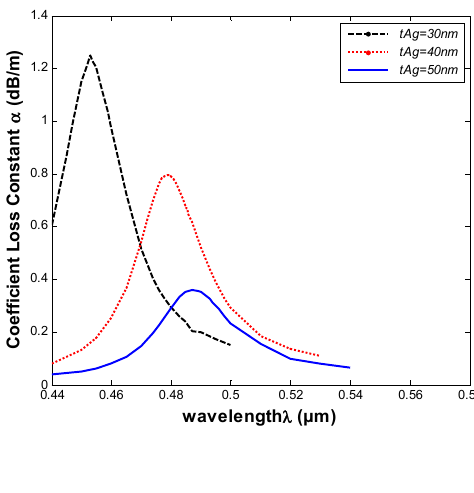
Figure 8. Loss spectra of the structure of Figure 5(a) at different silver layer thickness = 30 nm, 40 nm, 50 nm). Analyte refractive index (n (t Ag